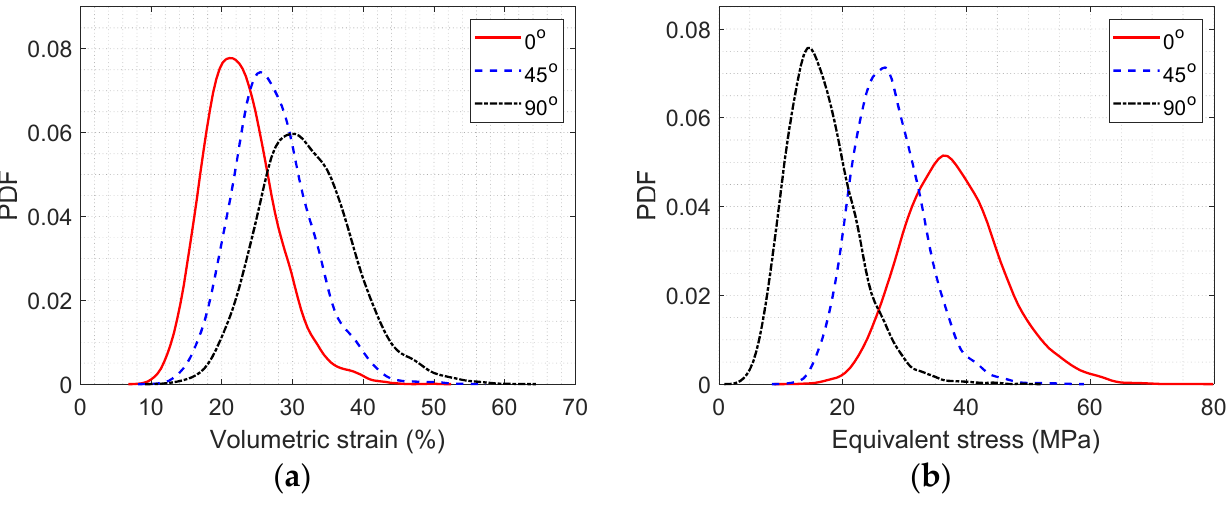
Figure 6. Probability density functions (PDF) of the volumetric deformation in the flexible liner ( a ) and of the equivalent stress in the concrete liner ( b ) at the springline, crown, and inclined angle 45° with respect to the springline. Table 3. Statistics of the volumetric strain and equivalent